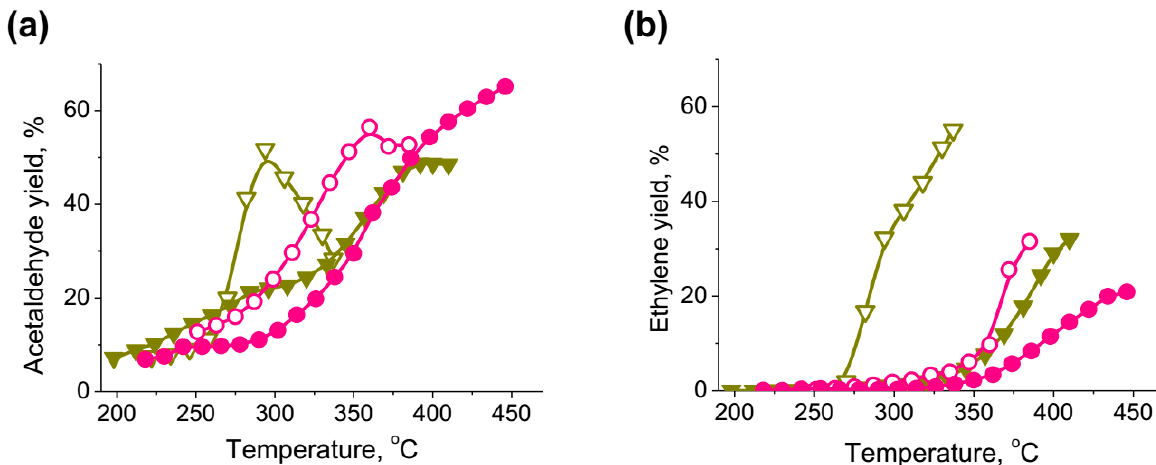
), Co@NC-ZIF ( (cid:53) ), Co@NC-GrSA ( • ) and (cid:35)